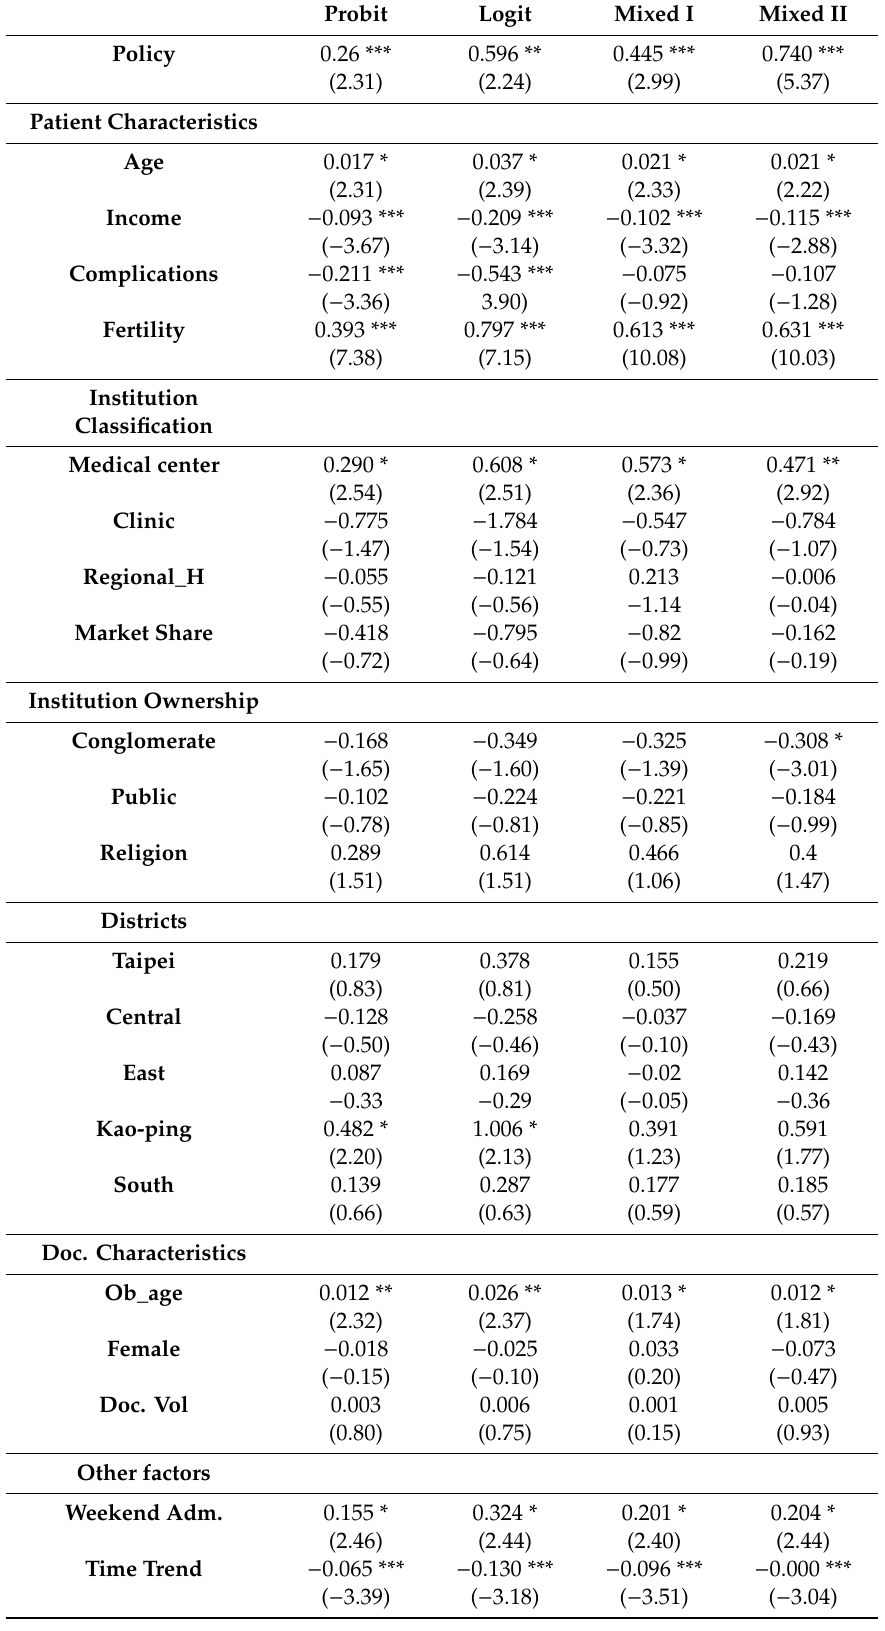
Table 3. Determinants of VBAC: Analysis Results from Di ff erent